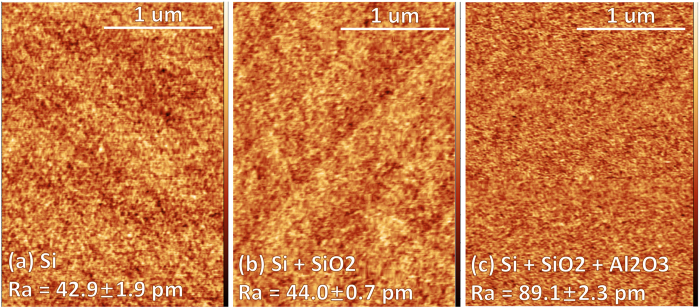
AFM measurements showing the morphology of different surfaces: (a) Si, height scale: 0.10–0.61 nm; (b) SiO2, height scale: 0.03–0.60 nm ; and (c) Al2O3, height scale: 0.03–1.16 nm.